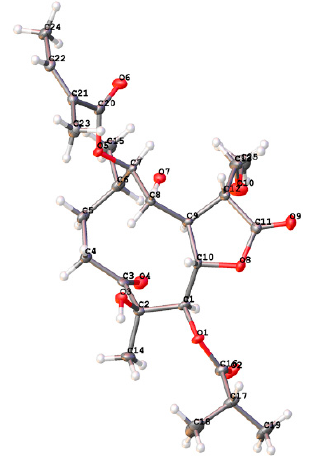
Figure 4. X-ray ORTEP drawing of 1 .